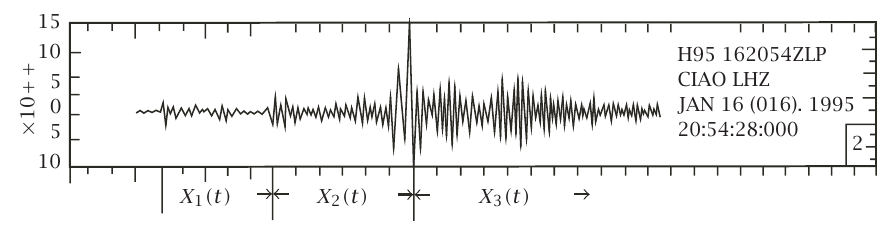
Figure 1.1 . Seismogram of the Kobe earthquake of 17 January, 1995 recorded at Charters